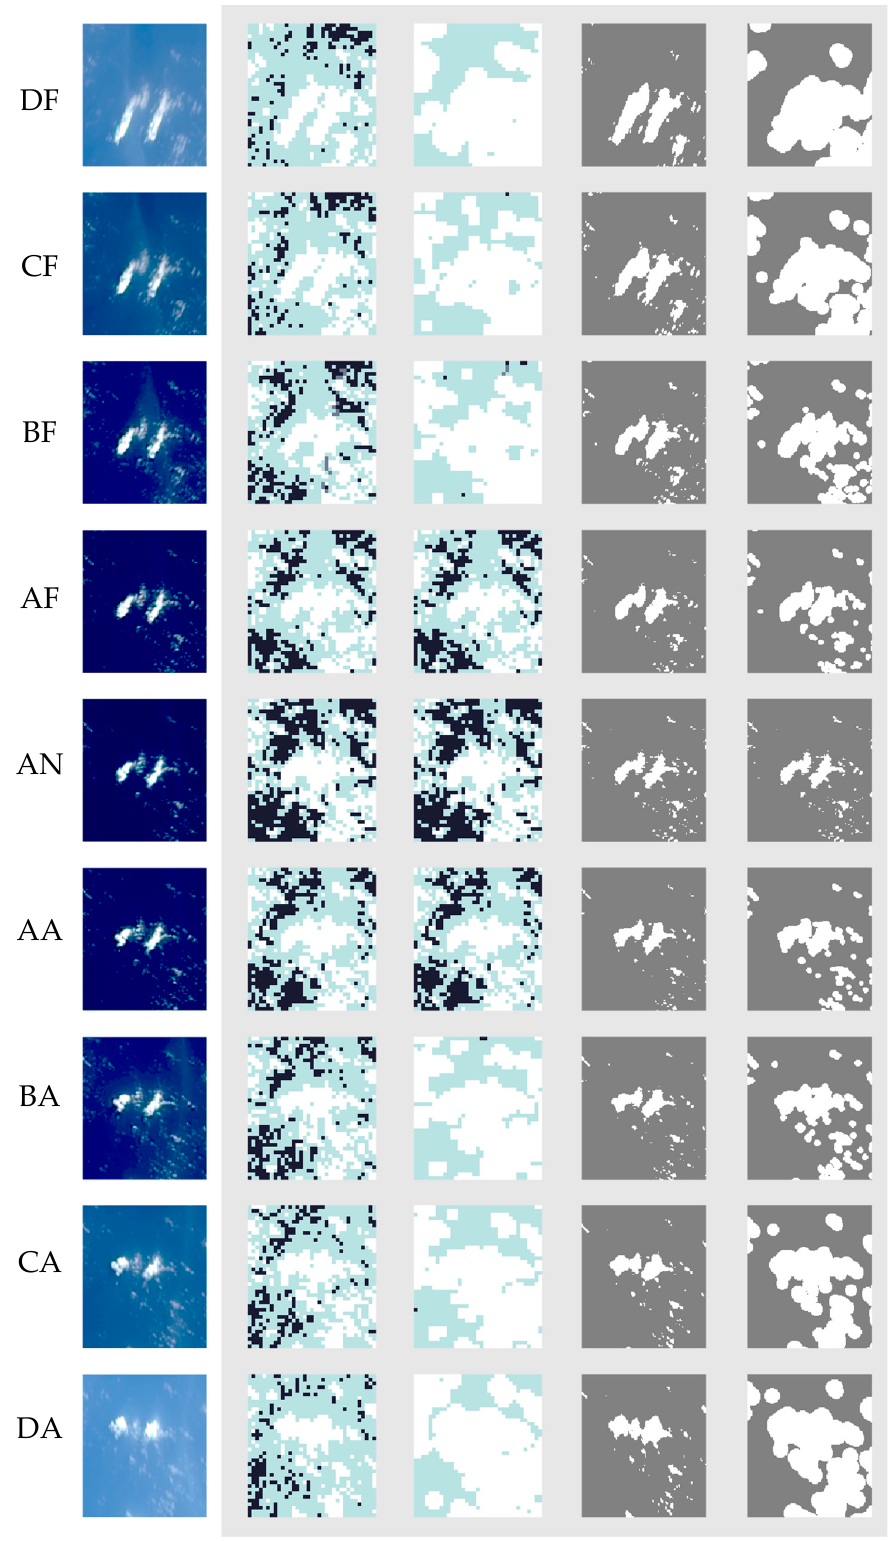
Figure 12. Same as Figure 8, but for the selected region in Orbit 1181 Block 91. The RGB images have been modified to increase the contrast between the ocean and the clouds for reader’s view.